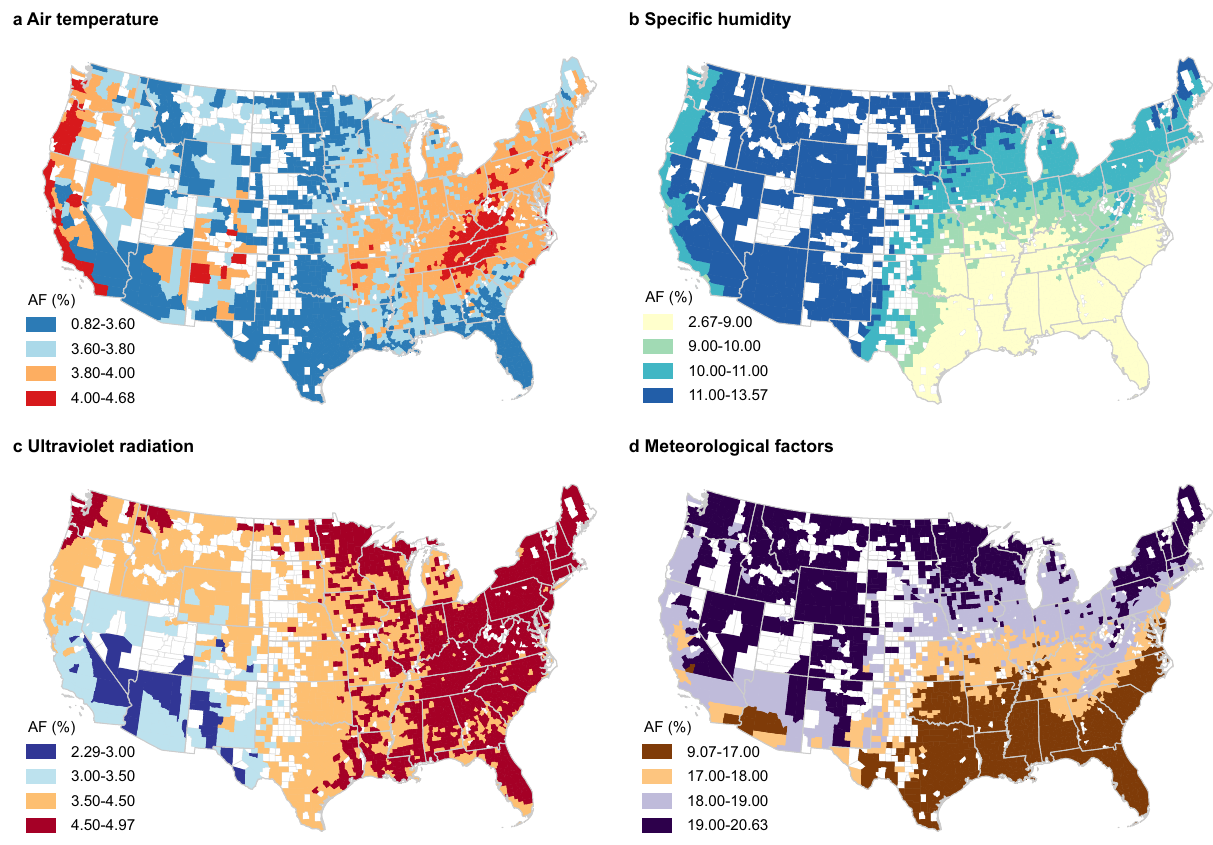
Fig. 3 Fractions of R t attributable to meteorological factors by county. The distribution of the fraction of reproduction number ( R t ) attributable to temperature ( a ), speci fi c humidity ( b ), ultraviolet radiation ( c ), or the sum of the three meteorological factors ( d ) (i.e., attributable fraction [AF]) in each county. The shape fi le in the maps was obtained from the U.S. Census